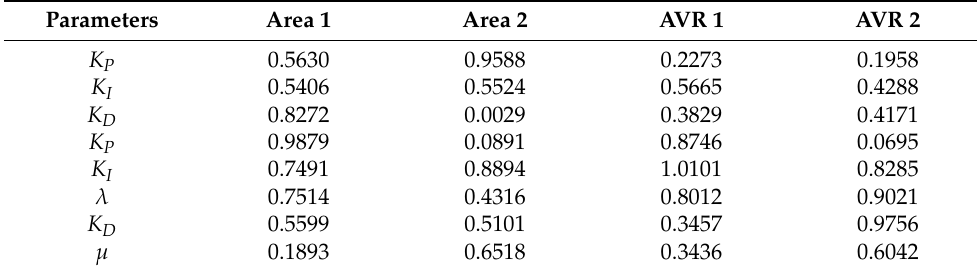
Table 8. Cascaded PID-FOPID controller gain for RLD, variable solar irradiations, and irregular wind